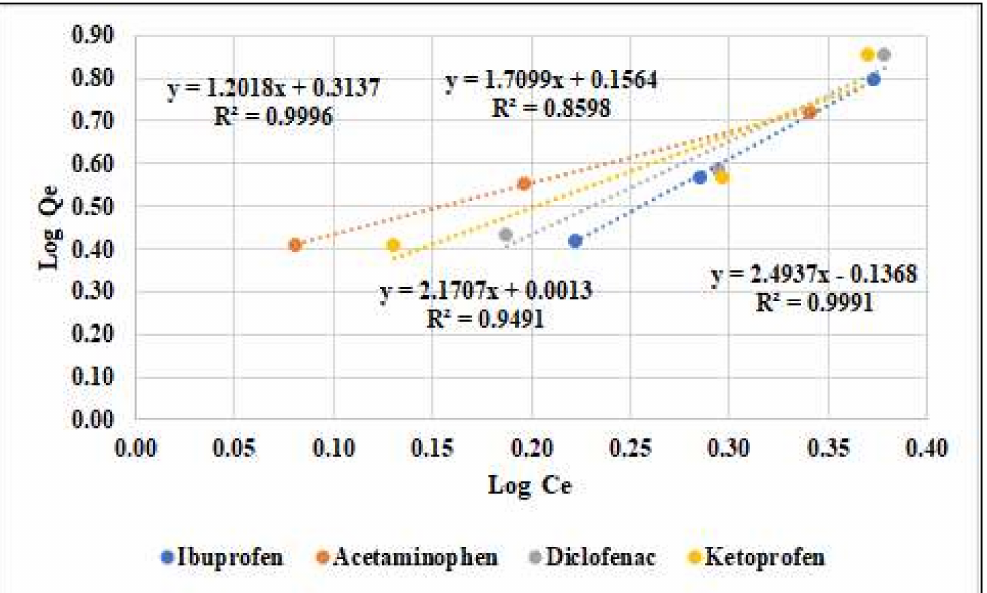
Figure 4. Freundlich linearized isotherm for ibuprofen, acetaminophen, diclofenac, and ketoprofen onto activated